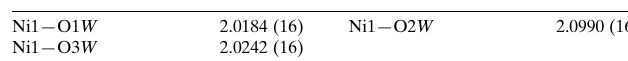
Selected bond lengths (A˚ ).